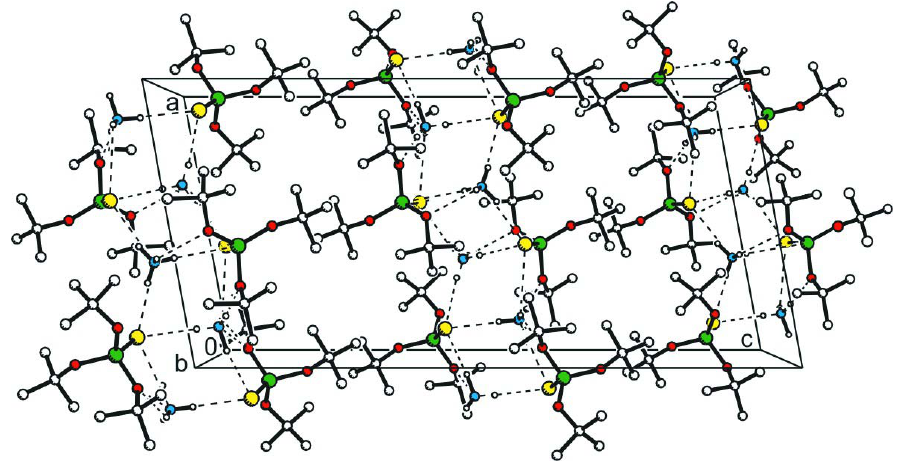
Figure 2 The chains of molecules of (I) linked by hydrogen bonds. A view direction is parallel to the crystallographic b axis. All t Bu H atoms have been omitted for clarity. Hydrogen bonds are indicated with dashed